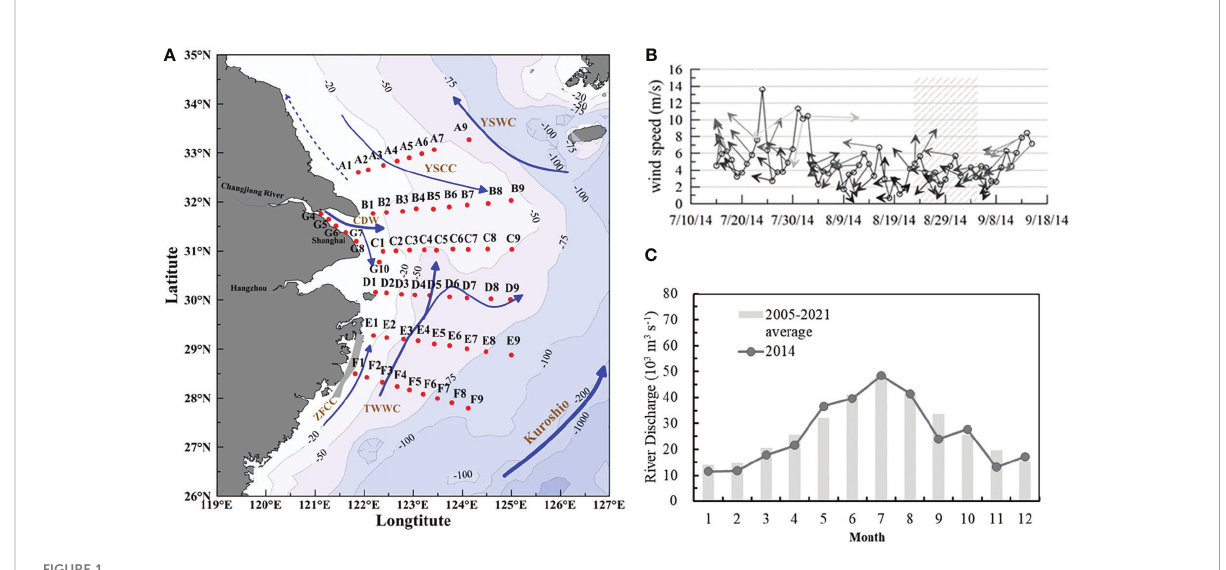
FIGURE 1 Study area and station map marked with coastal ocean currents. (A) Sampling stations are marked with solid red dots, and the solid blue arrow lines represent the primary circulation in the ECS in summer. The gray-shaded area is the upwelling area of Min – Zhejiang. (CDW, Changjiang diluted water; TWC, Taiwan warm current; YSWC, Yellow Sea warm current; YSCC, Yellow Sea coastal current; ZFCC, coastal current of Fujian and Zhejiang). (B) Daily wind pattern from July to September; shaded rectangle represents the sampling period. (C) Monthly averaged river discharge at Datong hydrological stations in 2014, and averaged 2005 –